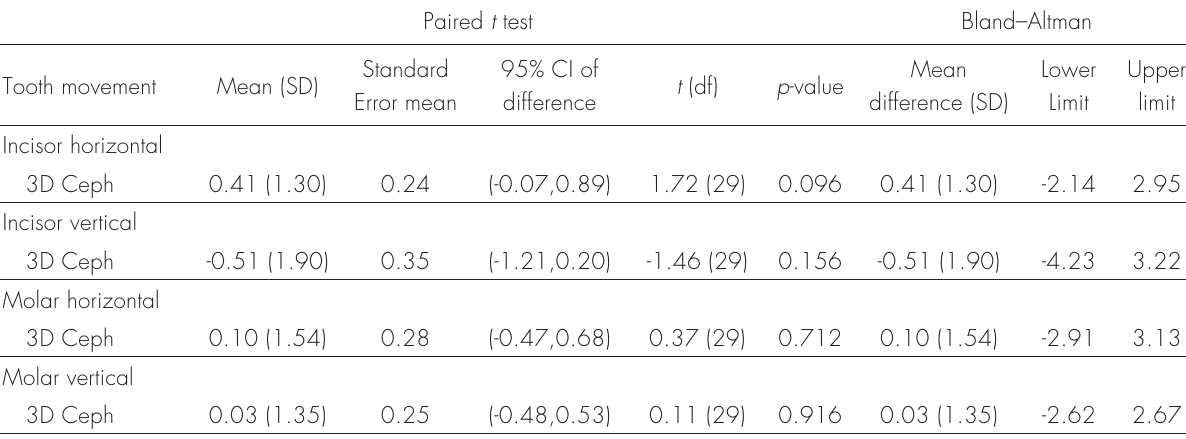
Table I. Bland-Altman analysis and paired t tests comparing horizontal and vertical tooth movement from 3D and cephalometric superimpositions. Paired t